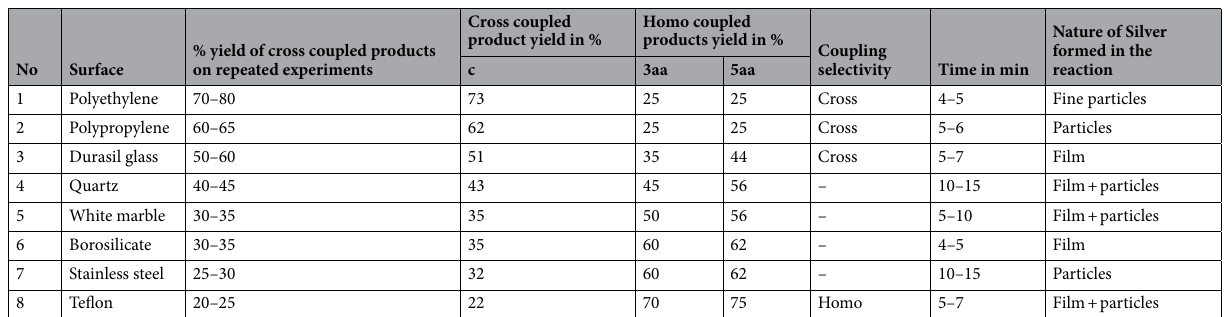
Table 2. Cross coupling between 3a and 5a in different types of containers. Time required for complete conversion, and % of isolated yield (after column) are reported. Range is given for cross-coupling products formed in the total yield in repeated experiments. (c and 3aa yields were calculate on the basis of 3a, 5aa yield was calculated on the basis of